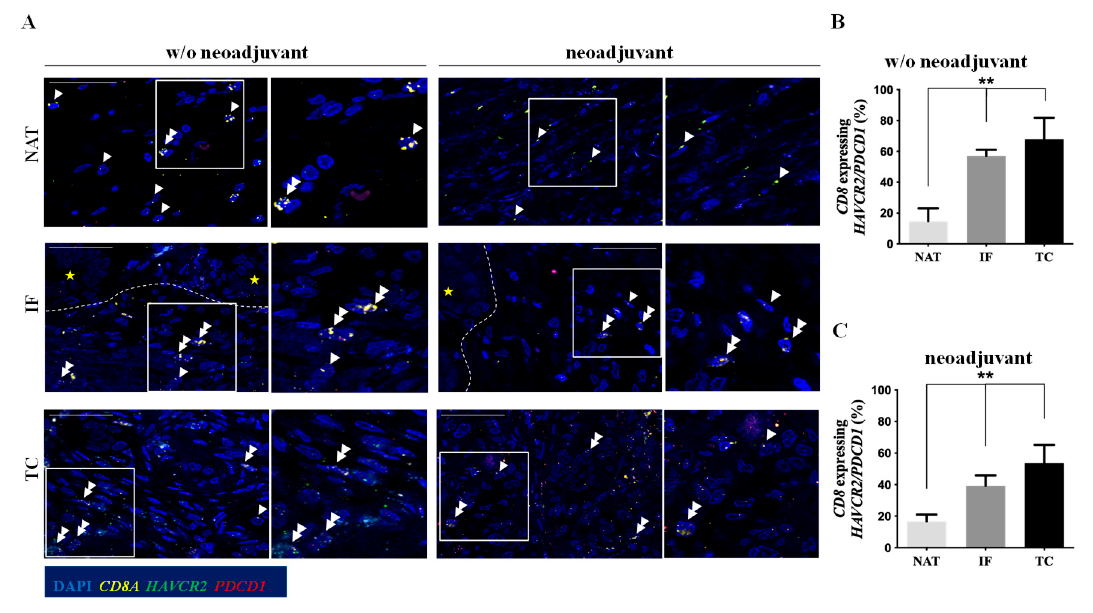
Figure 3. CD8+ T lymphocytes in the tumor center (TC) and the invasive front (IF) exhibit an exhausted phenotype. ( A ) RNAscope analysis to examine the co-expression of HAVCR2 (green) and/or PDCD1 (red) and CD8A (yellow) in PDAC patients. Representative confocal micrographs in PDAC patients without (w/o) neoadjuvant therapy and PDAC patients who received neoadjuvant chemotherapy. Dashed line delineates the invasive front (IF). Yellow asterisks depict cancer glands. Double arrowheads indicate CD8A -positive cells co-expressing HAVCR2/PDCD1 and single arrowheads depict only CD8A expressing T lymphocytes. Scale bar: 100 μ m ( B ) Quantification of CD8+ T lymphocytes expressing HAVCR2/PDCD1 mRNA in PDAC patients who did not receive neoadjuvant therapy. ** p -value < 0.01. Data are expressed as mean ± STDEV (N = 5). ( C ) Quantification of CD8+ T lymphocytes expressing HAVCR2/PDCD1 mRNA in PDAC patients who received neoadjuvant chemotherapy. ** p -value < 0.01. Data are expressed as mean ± STDEV (N = 3). Tumor center (TC), invasive front (IF), normal parenchyma adjacent to the tumor (NAT).